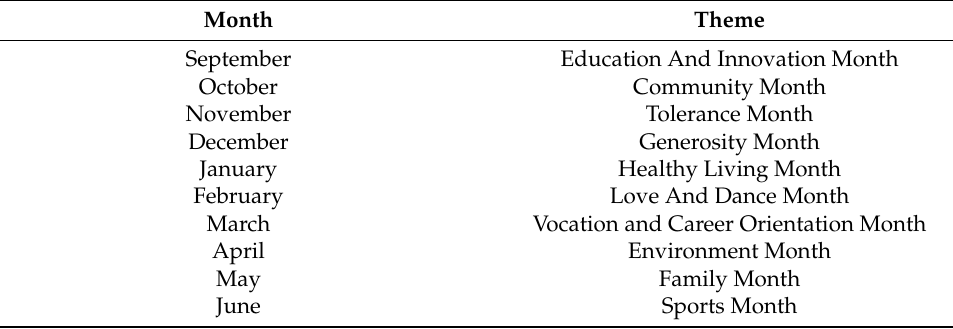
Table 1. Monthly themes for the club projects.